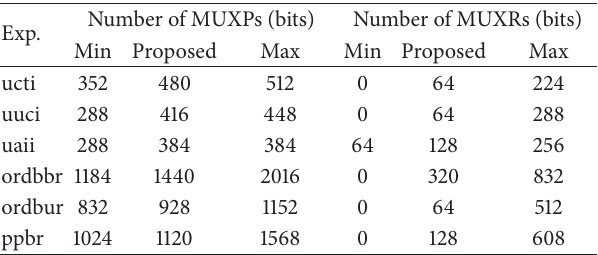
Table 3: Number of MUXPs and MUXRs. Exp.